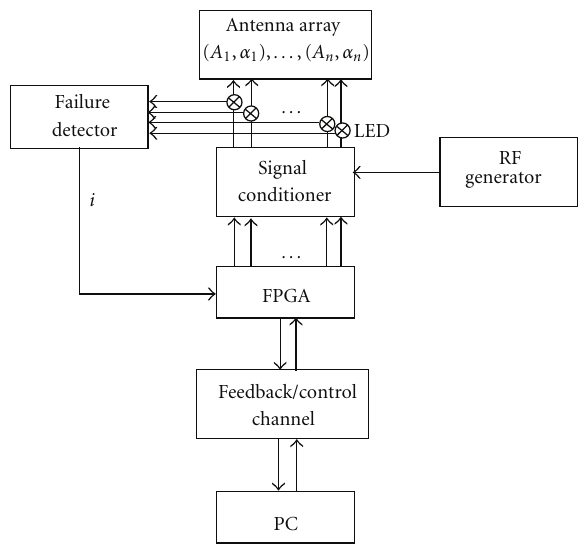
Figure 2: A concept of a self-recoverable antenna array system